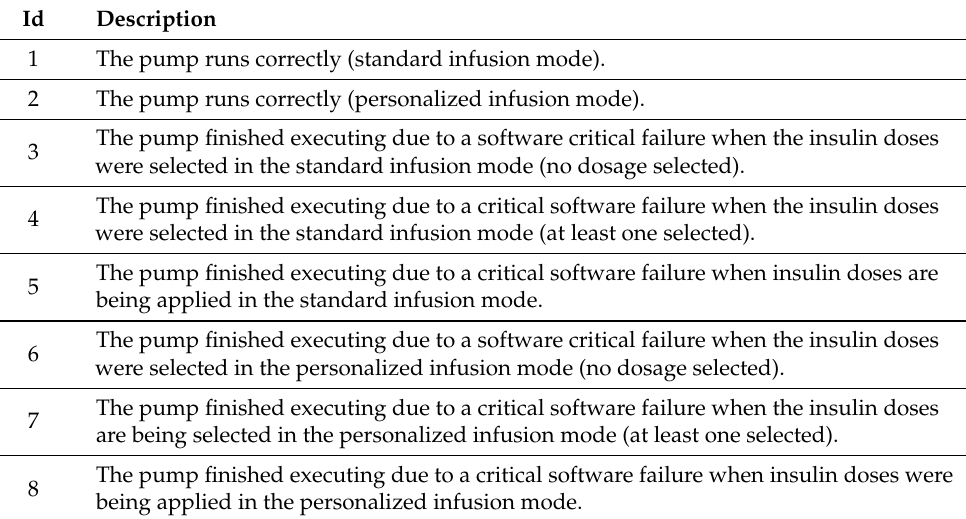
Table 1. Description of simulations conducted based on abstract